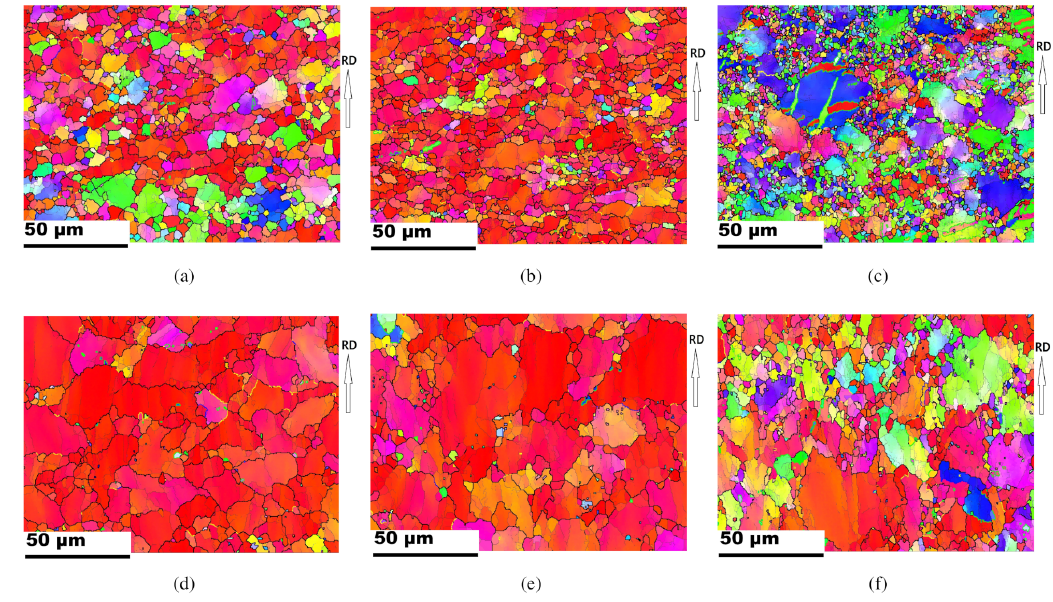
Figure 8. IPF maps of Part 1, Part 2, and Part 3 regions of drawn cups. The punch speed and working temperature during deep drawing were 30mm/min and 225 ◦ C, respectively. Each twin boundary of tensile, compressive, and double twins is specified with green, blue, and yellow. ( a ) Part 1, ( b ) Part 2, and ( c ) Part 3 for TRC sheets. ( d ) Part 1, ( e ) Part 2, and ( f ) Part 3 for IC